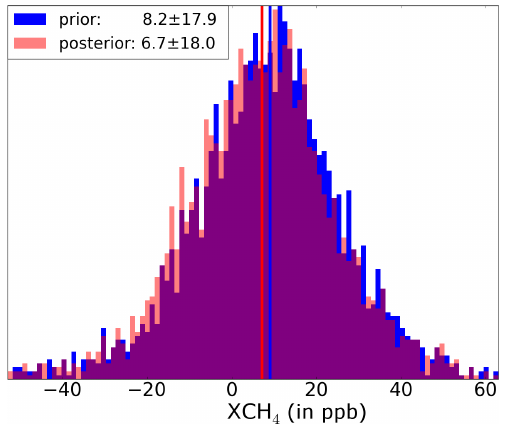
Figure 7. Distribution of the differences (inppb) between the ob- served and simulated prior and posterior GOSAT total columns. The differences are computed only for the GOSAT observations down- wind the emissions constrained by the surface sites, i.e. with a sim- ulated contribution from these regions to the total column bigger than 2ppb.